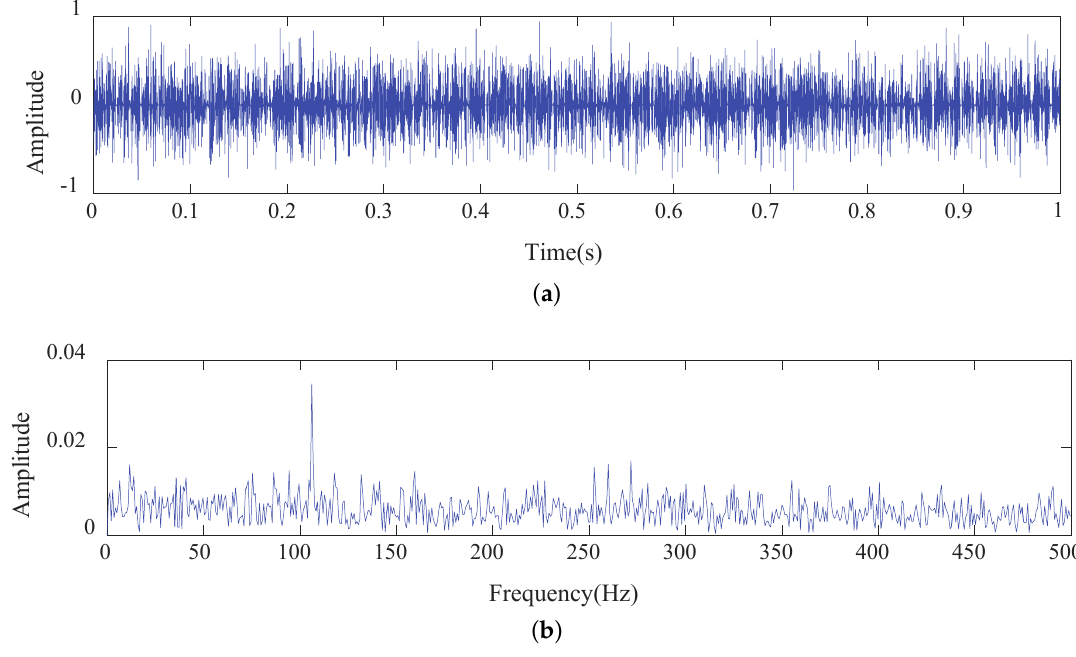
Figure 17. Results of OGS: ( a ) Time-domain waveform. ( b ) Envelope